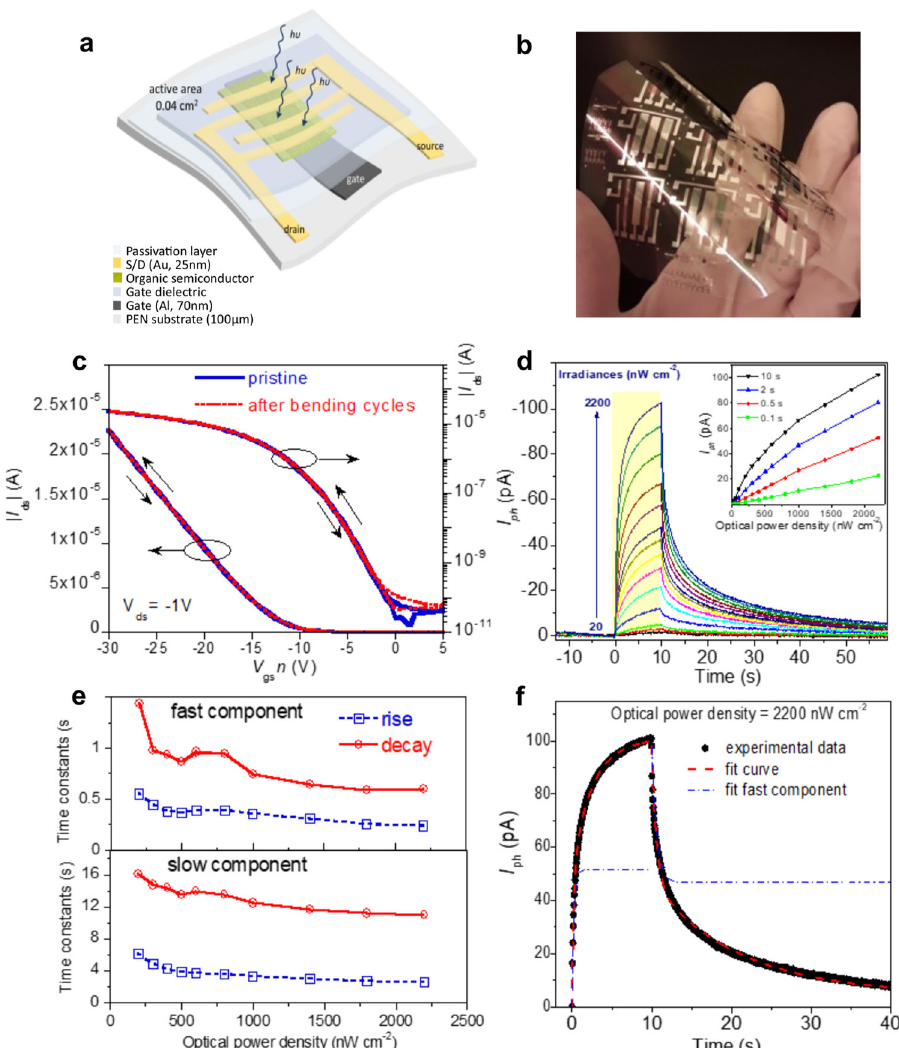
Fig. 3 Characterization of the organic phototransistor. a Phototransistor scheme (out of scale). b Sample picture. c Typical transfer characteristics of the device before and after 100 cycles of strain bending perpendicular to the channel. Forward and reverse curves are reported, as indicated by the up/down arrows. d Dynamic photoresponse of the OPT under different irradiations at λ = 460 nm. Exposition time t exp = 10 s, V ds = − 1 V, V gs = − 3.5 V. In the inset, the photocurrent is reported as a function of the optical power for different exposition times. e Characteristic τ of the signal formation and decay as a function of the pulse optical intensity. f OPT photoresponse to a 2200 nW cm − 2 light pulse with superimposed the fi tted curve (red dashed line). Details of the fast component contribution to the formation and decay (blue line) processes are also